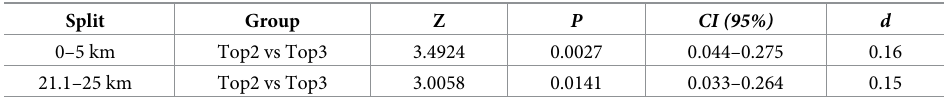
Table 2. Relationship between groups and average pace of competition in